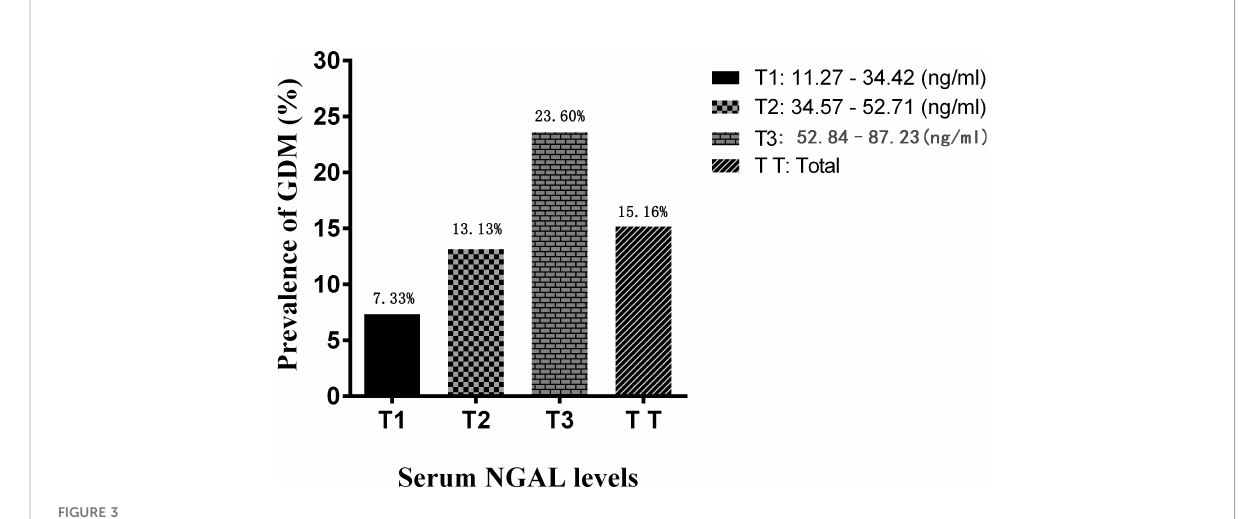
FIGURE 3 Prevalence of GDM for each tertile of serum NGAL